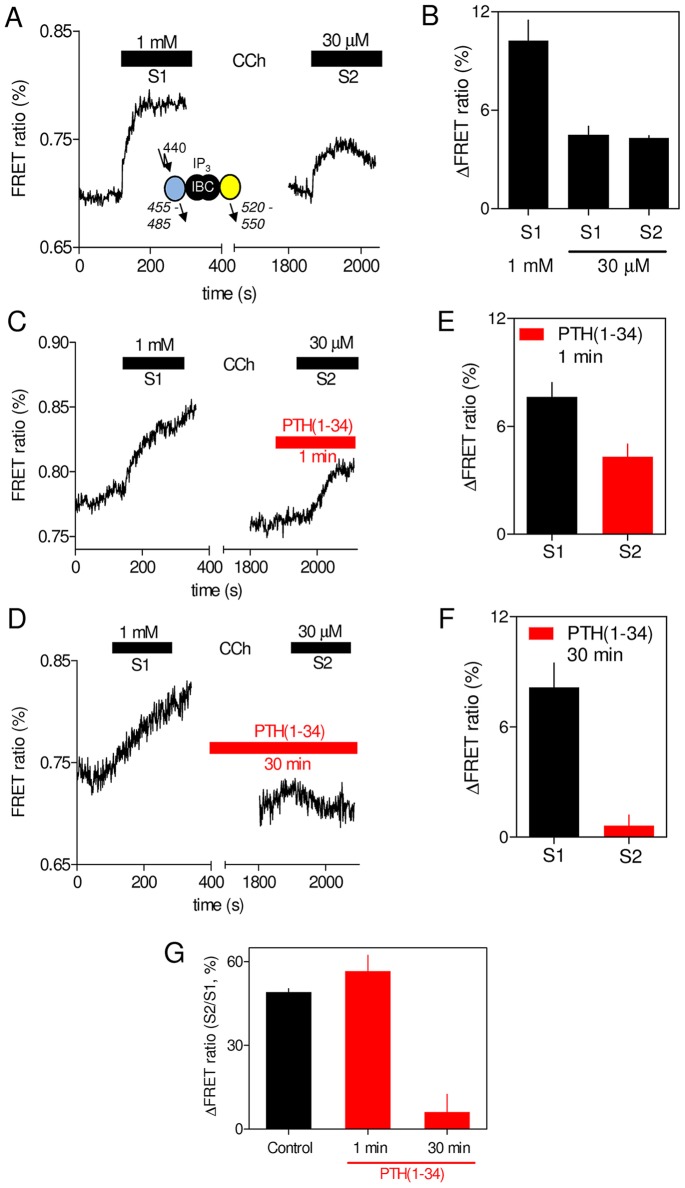
Sustained stimulation with PTH(1-34) reduces carbachol-evoked increases in cytosolic IP3 concentration. (A) Cytosolic IP3 was measured in single HEK-PR1 cells using a FRET sensor during stimulation (3 min) with 1 mM carbachol (CCh) (S1) and then, after washing, with 30 µM carbachol added 30 min later (S2). The trace shows typical results from a cell with no intervening PTH treatment. FRET is denoted as CFP:YFP fluorescence ratio, so that an increased signal (decreased FRET) corresponds to an increase in IP3 concentration (see Materials and Methods). The inset shows the IP3 sensor with excitation and emission (italics) wavelengths in nm. IBC, IP3-binding core. (B) Summary results (mean±s.e.m. for 62 cells from six coverslips) showing ΔFRET (stimulated/basal signal) for cells stimulated with the indicated carbachol concentrations presented as either the first (S1) or second stimulus (S2, i.e. after 1 mM carbachol). (C,D) Typical results from single cells subject to similar treatments to those in A, but with PTH(1-34) (100 nM) added 1 min (C) or 30 min (D) before, and then during, the second addition of carbachol. (E,F) Summary results show ΔFRET for the first and second carbachol stimulation (S1 and S2) as mean±s.e.m. for 36 and 34 cells from five (E) and seven (F) coverslips. (G) For each cell, ΔFRET measurements for the first (S1, 1 mM carbachol) and second stimulus (S2, 30 µM carbachol) were used to calculate S2/S1 for the indicated treatments. Results are mean±s.e.m. for 28–36 cells.